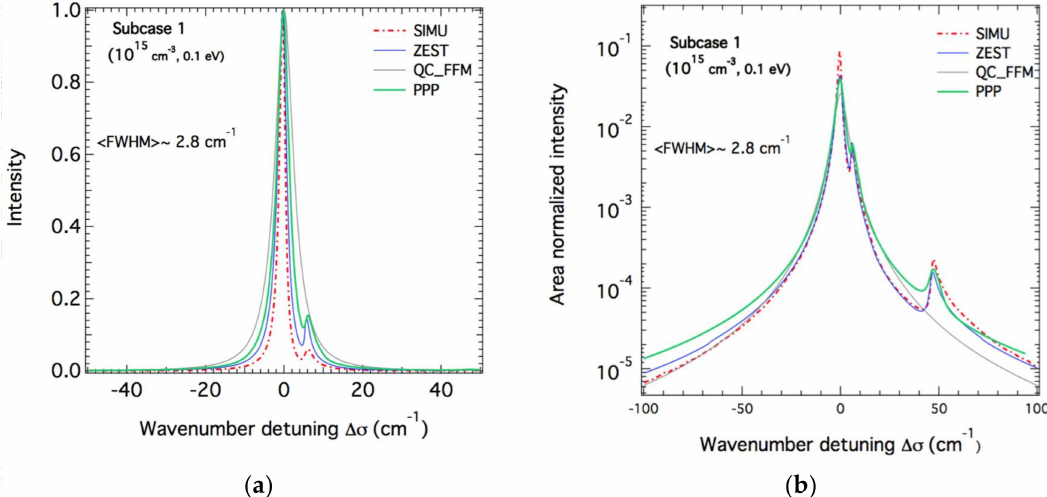
Figure 1. Theoretical Stark profiles of the He I 492 nm line calculated for helium plasma with an electron density of 10 15 cm − 3 and a temperature of 0.1 eV for both plasma He + ions and electrons corresponding to subcase 1. The profiles are centered at 492 nm and expressed as wavenumbers using cm − 1 units. ( a ) Linear scale. ( b ) The profiles are the same but they are area normalized and plotted using a semi-logarithmic scale to highlight the differences between the different calculations. In both ( a , b ), the average FWHM is shown. Red dot-dashed line: SimU, solid blue: ZEST, solid green: PPP, solid grey: QC_FFM.